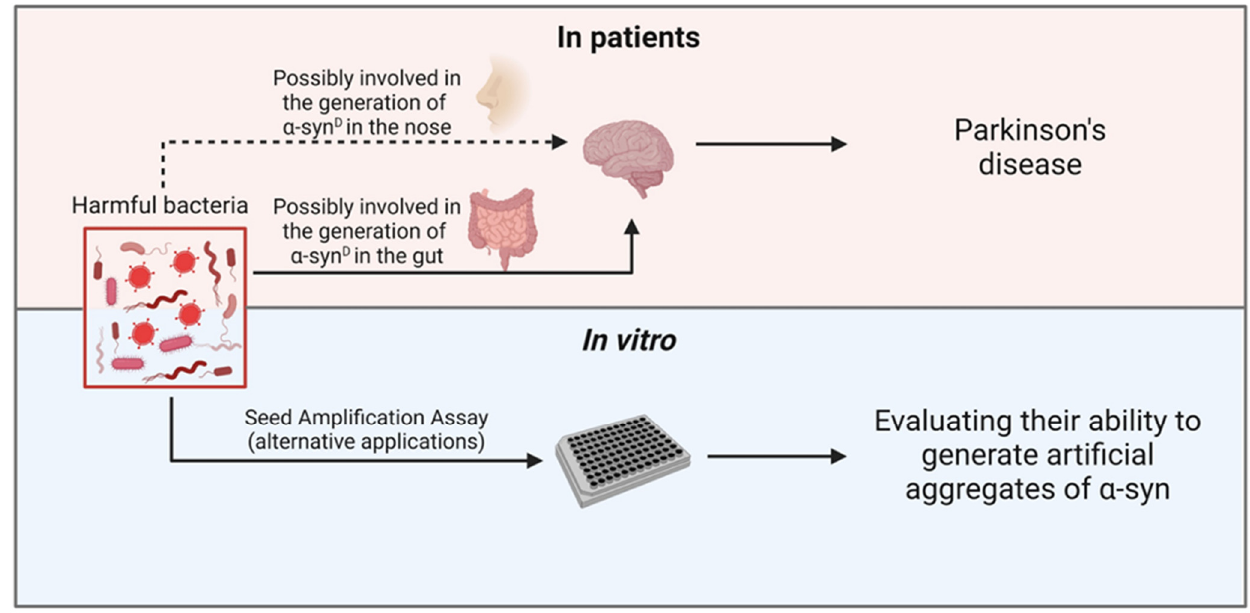
Figure 1. Schematic overview of the principal topics described in the review.